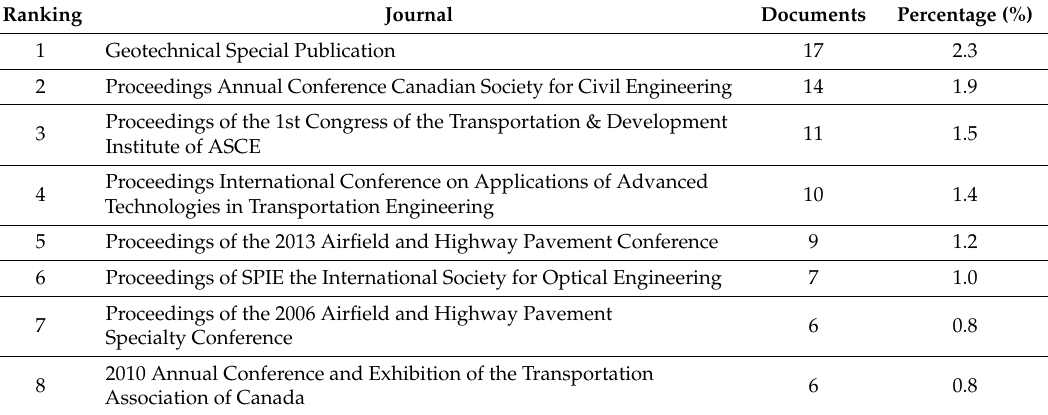
Table 1. The most important congresses and conference proceedings (with more than 5